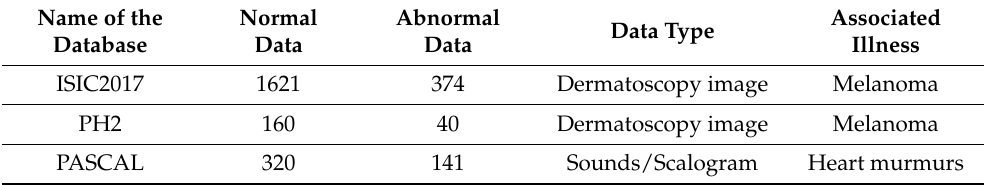
Table 2. Summary table of the most relevant characteristics of the ISI2017, PH2, and Pascal datasets.